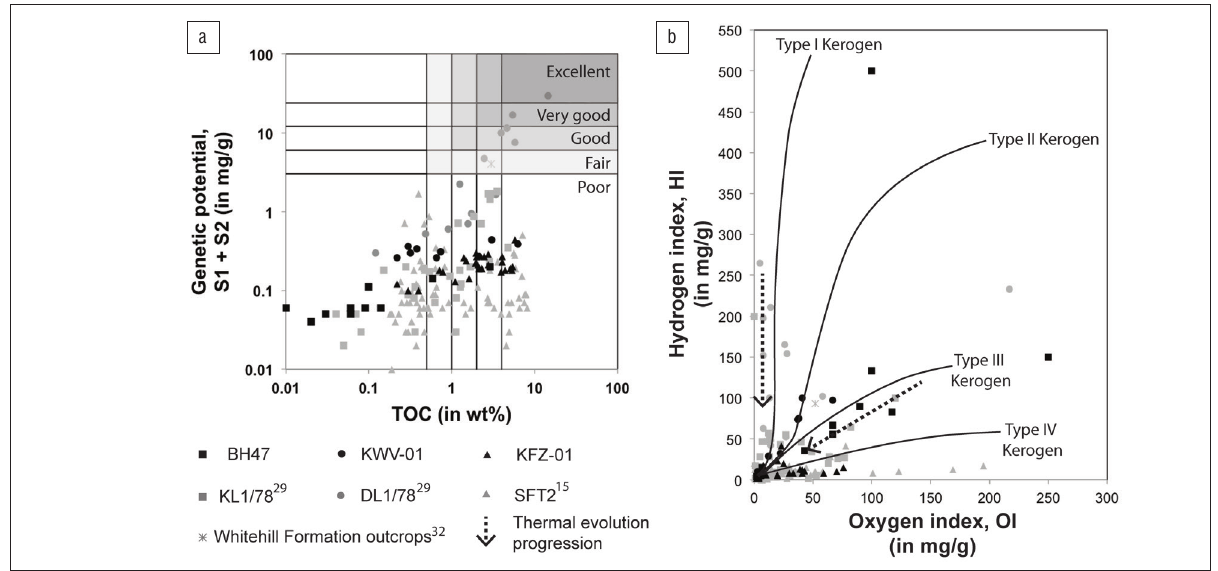
Figure 7: (a) Classification of kerogen quality in the Ecca Group carbonaceous shales. 31 (b) A modified Krevelen diagram 31 indicates the dominance of Type III and IV kerogen in Ecca Group shales of KZF-01, BH 47 and KWV-01 with reference to other studies in the Karoo basin as indicated.